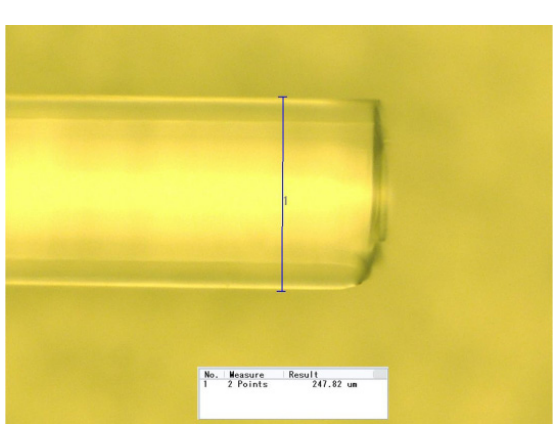
Figure 6. Microscope figure of the optical fiber cut by optical fiber cleaver.